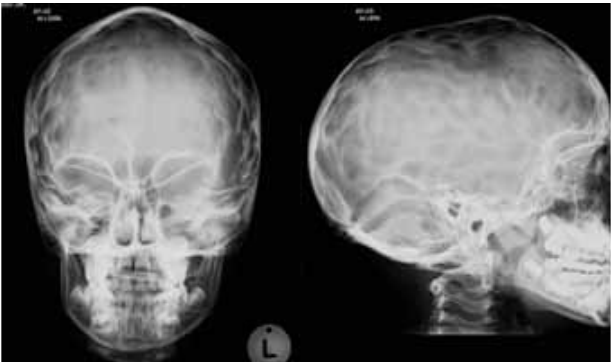
Fig. 1. PA and lateral skull X-rays demonstrating impressive convolutional markings (copper-beaten skull appearance) in a 6-year-old girl with known craniosynostosis. Note associated fusion of the saggital, coronal and lamdoid sutures.